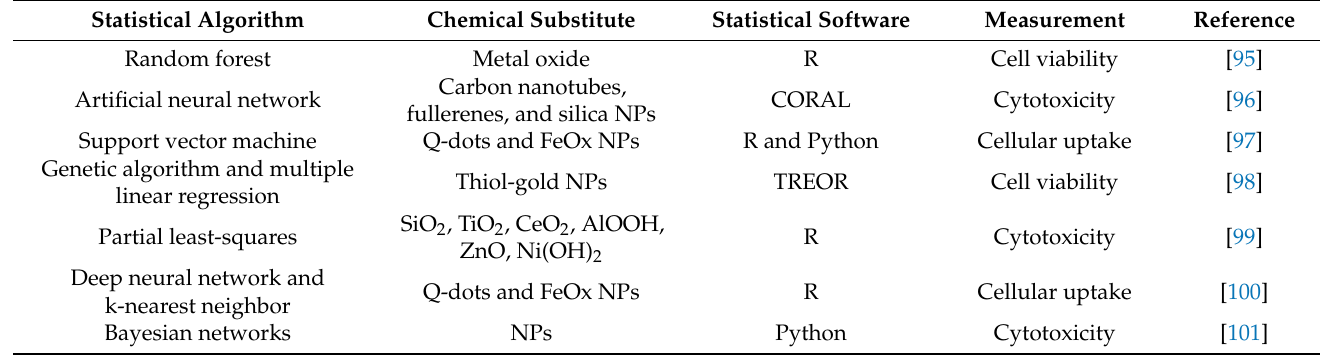
Table 2. Main approaches of QSAR models for nanotoxicity